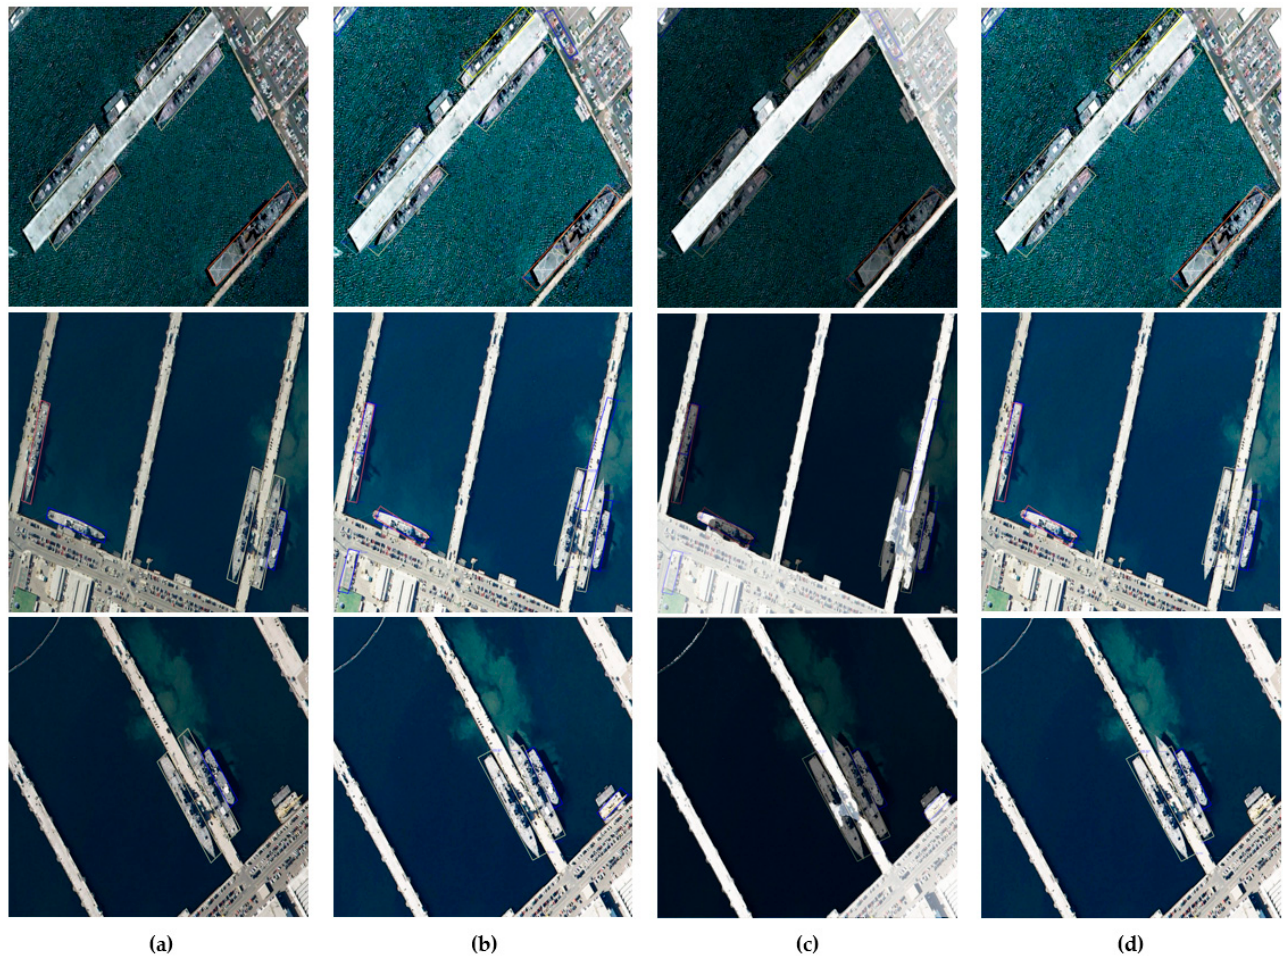
Figure 11. MSD ship detection results applying GFEP and FDSESI based on the HRSC2016 test dataset. ( a ) Ground truth; ( b ) GFEP; ( c ) Sea and land segmentation mask overlaid on GFEP; ( d ) Results of applying FDSESI. Table 4. Ablation study based on HRSC2016 dataset.